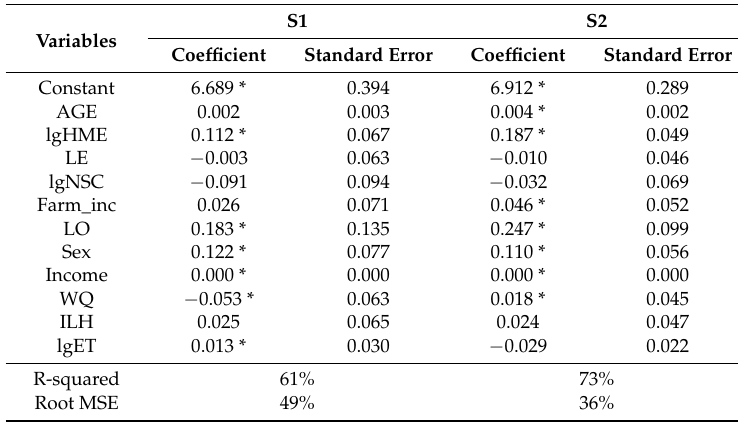
Table 6. Results of Multiple Linear Regression for scenarios S1 and